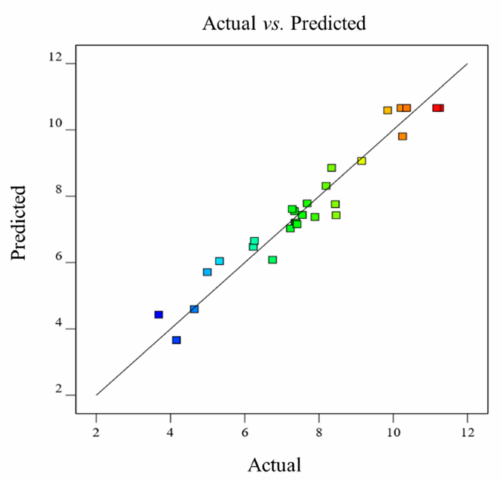
Figure 4. Comparison between actual vs. predicted yield of MPM obtained from MP seeds.